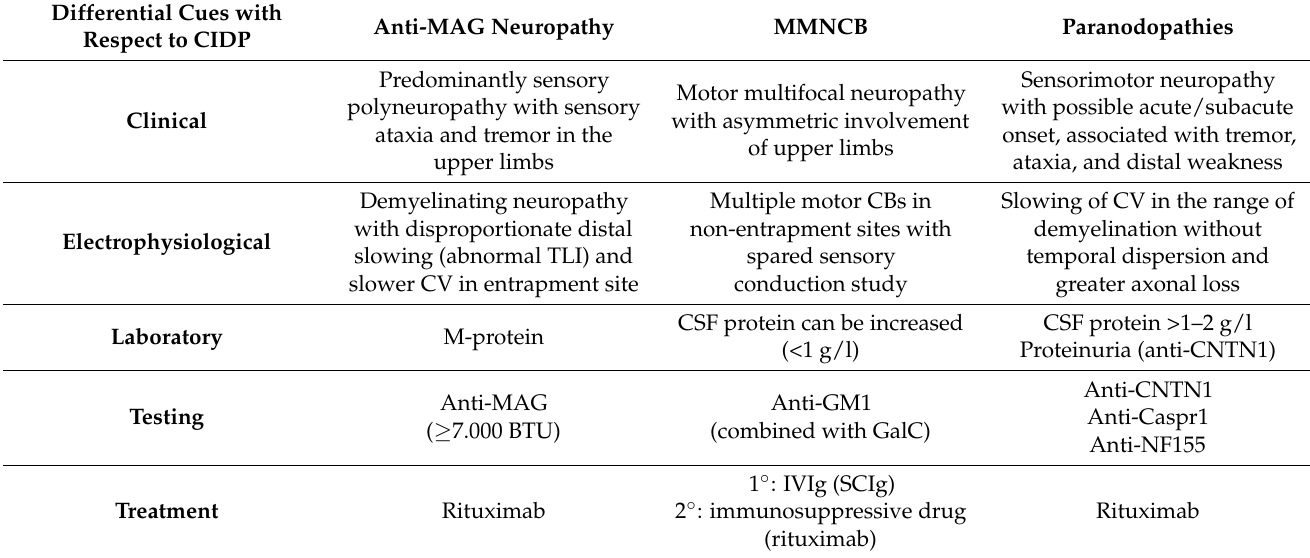
Table 1. Main features of chronic dysimmune autoantibody-related neuropathies. Differential Cues